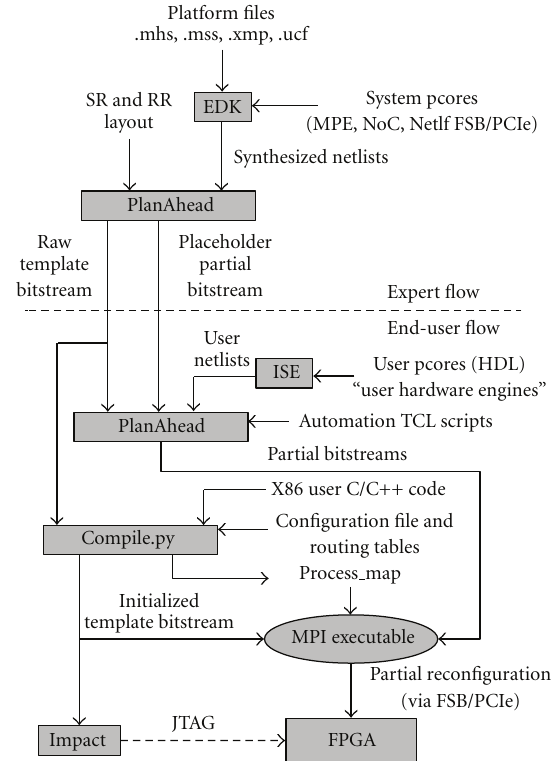
Figure 8: Expert and end-user software flows to generate template bitstreams, partial bitstreams, and the message-passing